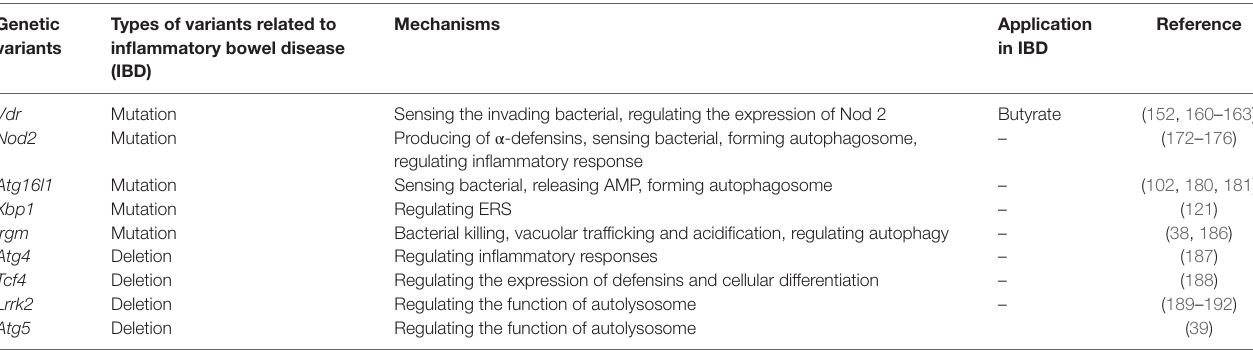
TABLe 1 | Genetic variants related to autophagy in Paneth cells. genetic